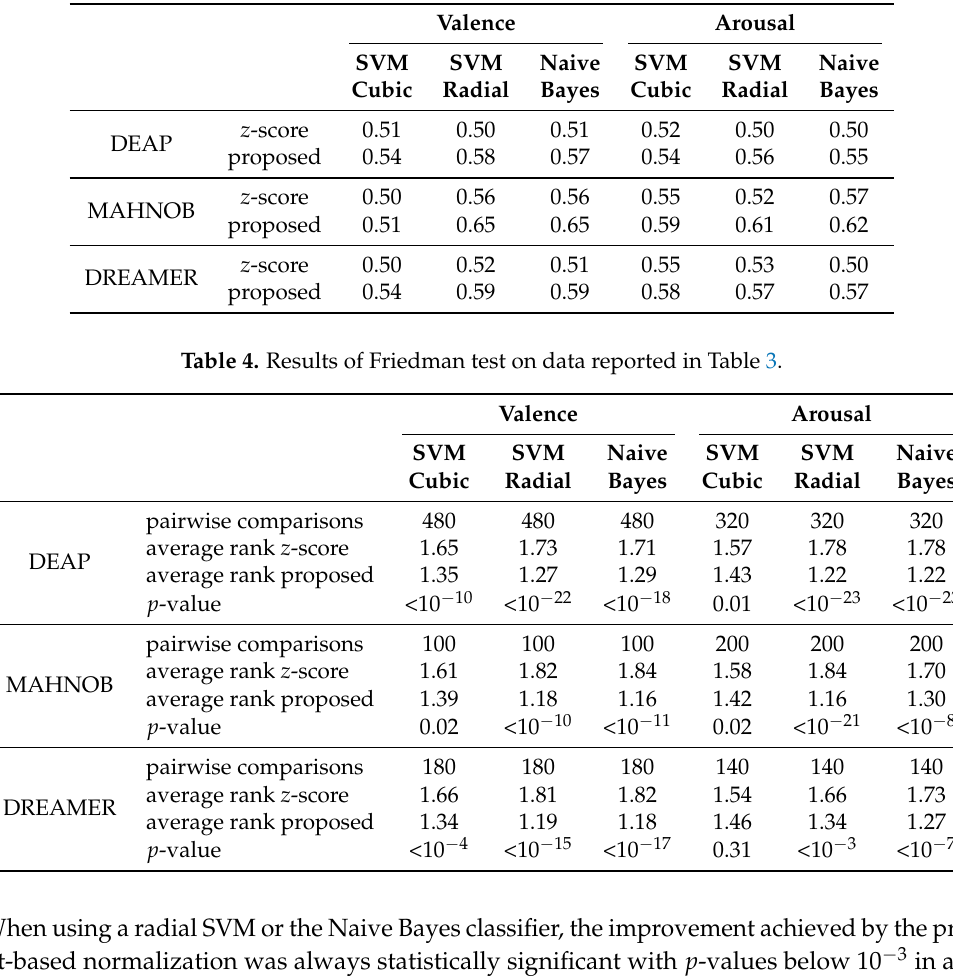
Table 3. Results obtained with a typical z -score normalization and with the proposed data transformation.